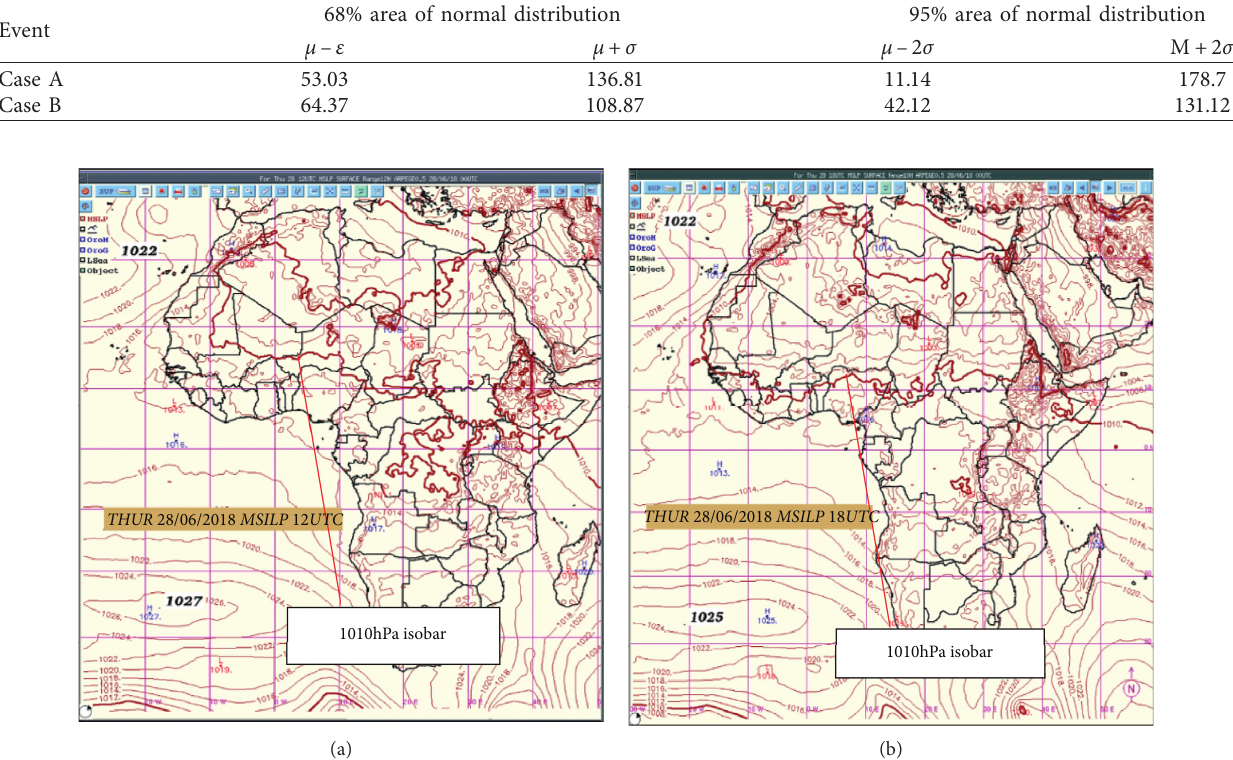
Figure 11: Meteo France Arpege 0.5 MSLP charts. (a) 12 UTC and (b) 18 UTC for case B.